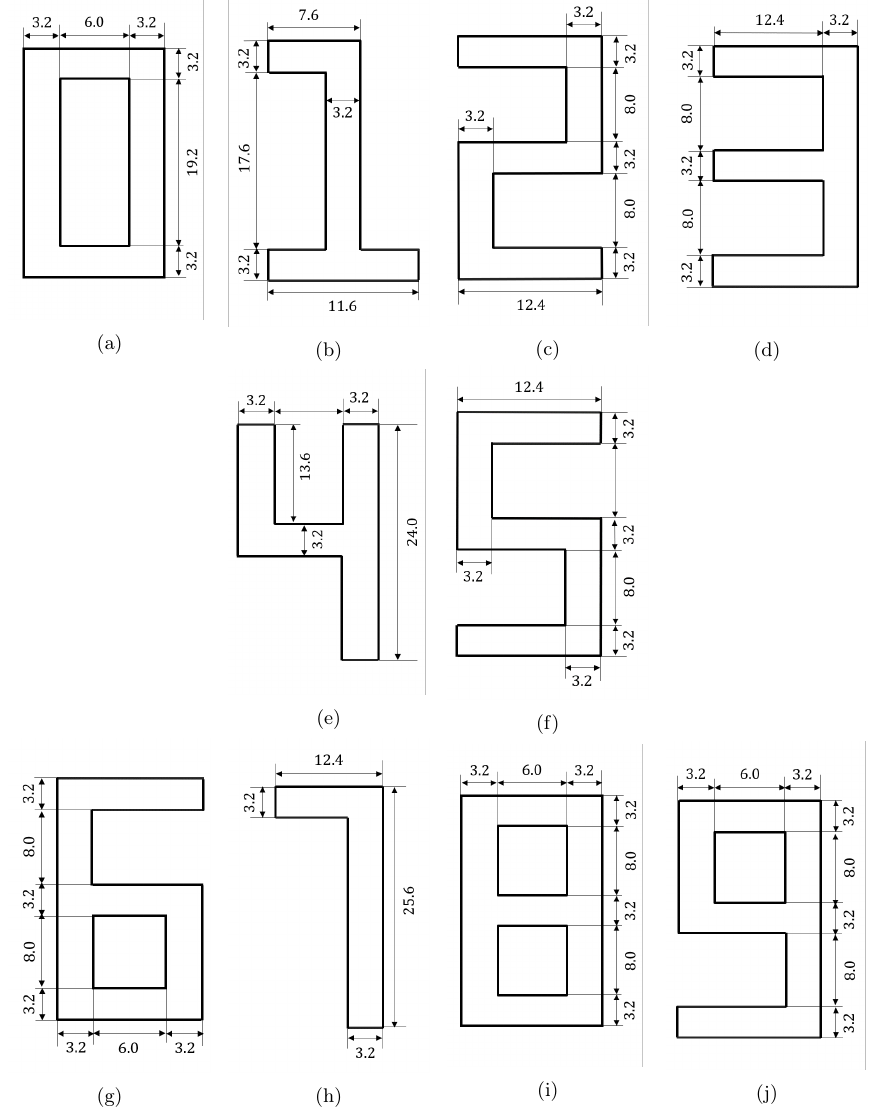
Figure 8: Schematic diagram of the digits (not to scale). All the dimensions are in mm scale. Figure A1. Schematic diagram of the digits (not to scale), panels a – j depict digits 0–9. All the dimensions are in mm